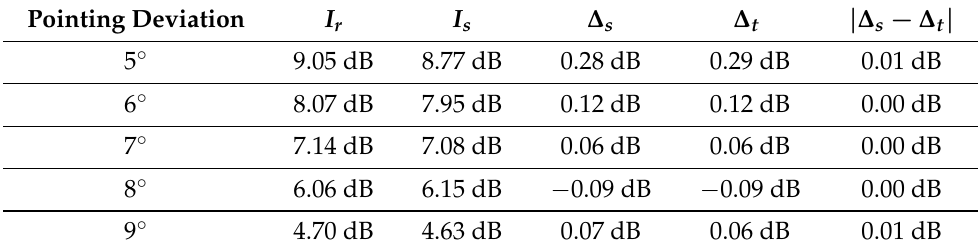
Table 3. The point target energy analysis in the case of misalignment.